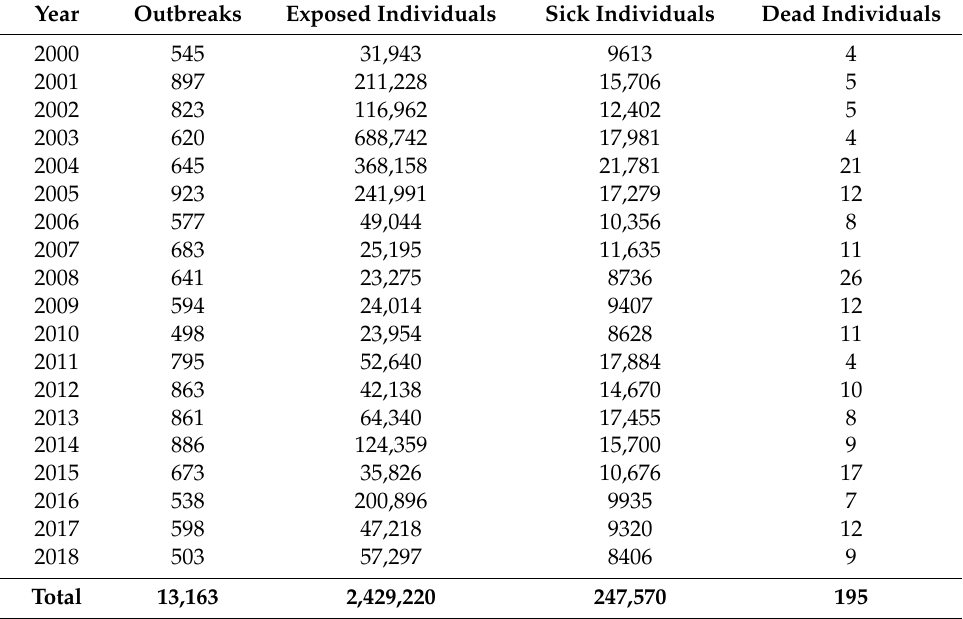
Table 1. Data of foodborne disease outbreaks reported in Brazil between 2000 and